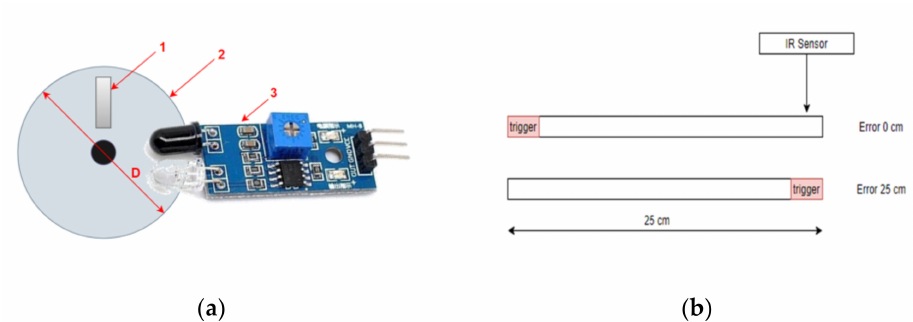
Figure 6. Measuring the distance: ( a ) spinning wheel: (1) trigger, (2) circumference of the wheel, (3) counter; ( b ) minimum error is 0 cm when the trigger is about to be in front of the IR sensor, maximum error is 25 cm when the trigger is directly in front of the IR